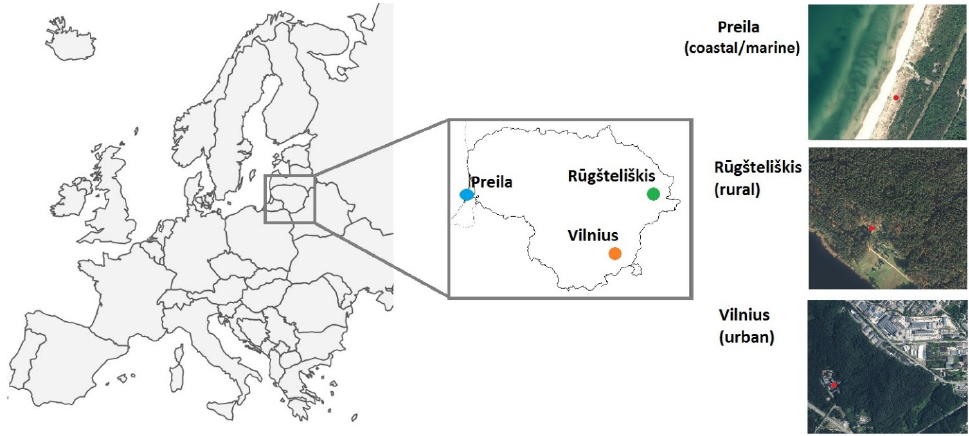
Figure 1. Map of Lithuania and the sampling